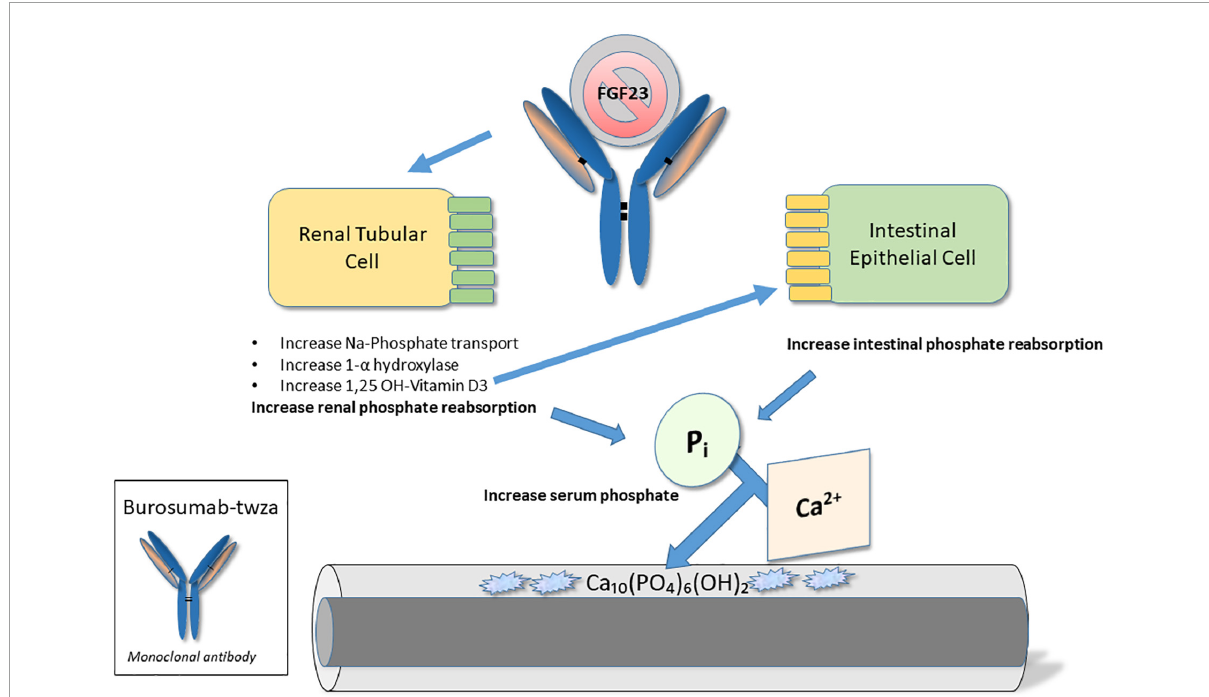
FIGURE2 Molecular mechanism of action – Burosumab-twza. Burosumab-twsa is a human IgG1 monoclonal antibody that inhibits fibroblast growth factor (FGF)-23 action in the kidney. In so doing, it directly enhances phosphate (Pi) resorption from the kidney. In addition, through effects on vitamin D metabolism it indirectly enhances Pi reabsorption from the intestine. The resulting increase in serum Pi promotes improved bone quality and